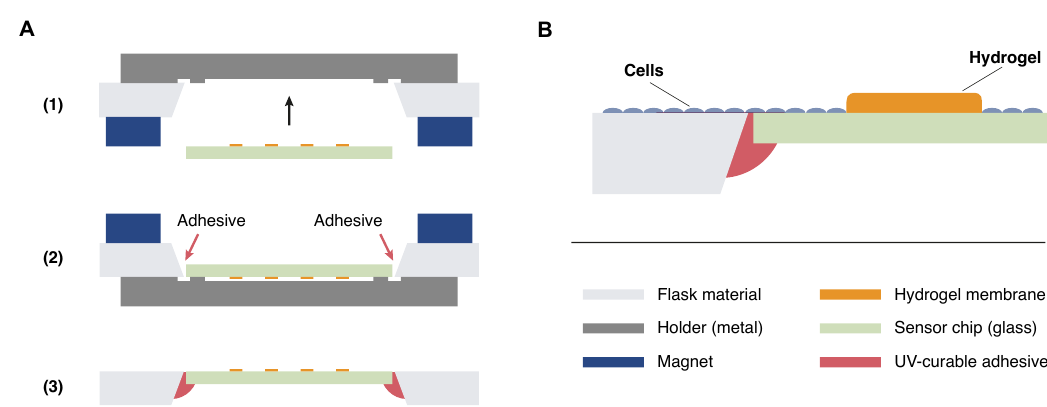
Figure 2. ( A ) Hybrid integration of the sensor chips in a milled opening in the bottom of a cell culture flask. A metallic holder was brought inside the flask and fixed with magnets from outside (1). The flask was flipped, sensor chips were positioned in a opening milled into the bottom, and UV-curable adhesive was applied (2). After curing, the magnets were removed and the holder released through the neck of the flask resulting in a positioned chip with its surface in-plane with the flask surface (3); ( B ) Schematic representation of the cell layer. Cells are supposed to settle on the flask and chip surface but not on the hydrogel membranes covering the sensor electrodes.